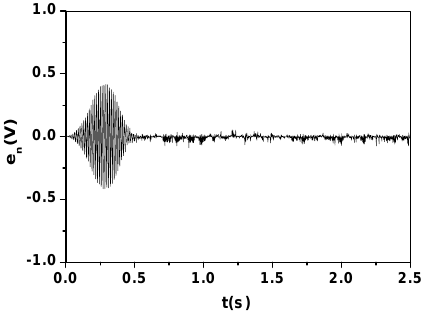
Fig. 16. Error function based on the transform-domain LMS algorithm for the case C 4